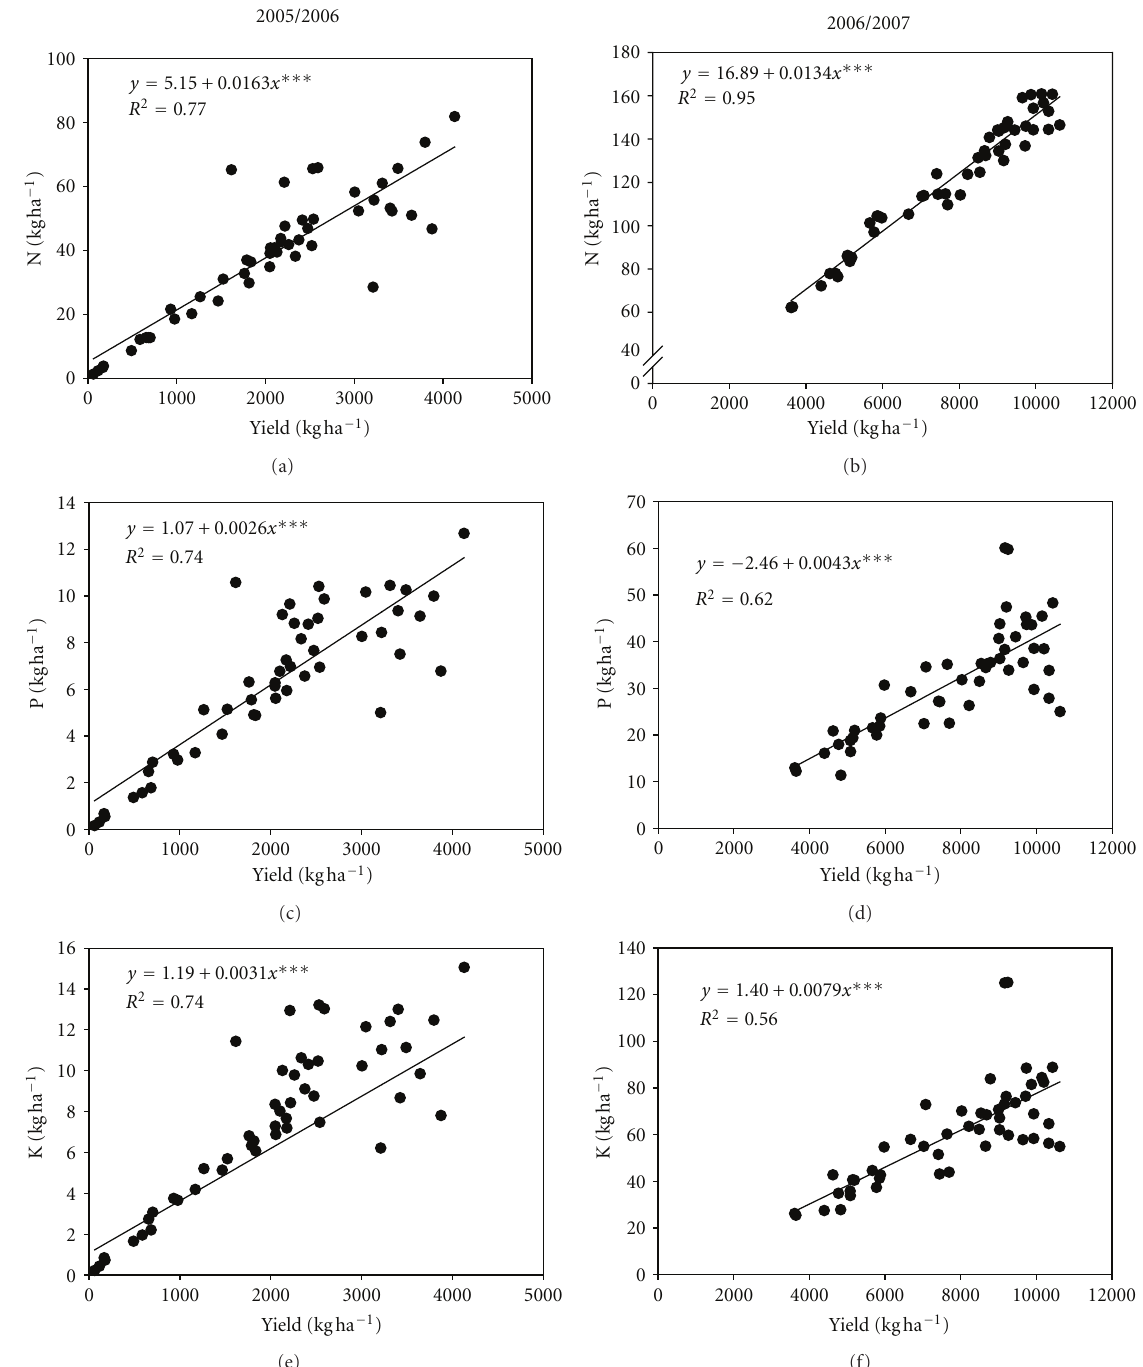
Figure 2: Regression between yield (kgha − 1 ) and exportation of N, P, and K (kgha − 1 ) in the grain in ten corn cultivars representing five di ff erent technological levels harvesting in 2006 and 2007, at Rolandia County, Paran´a State, Brazil. ∗∗∗ P < 0 . 001.